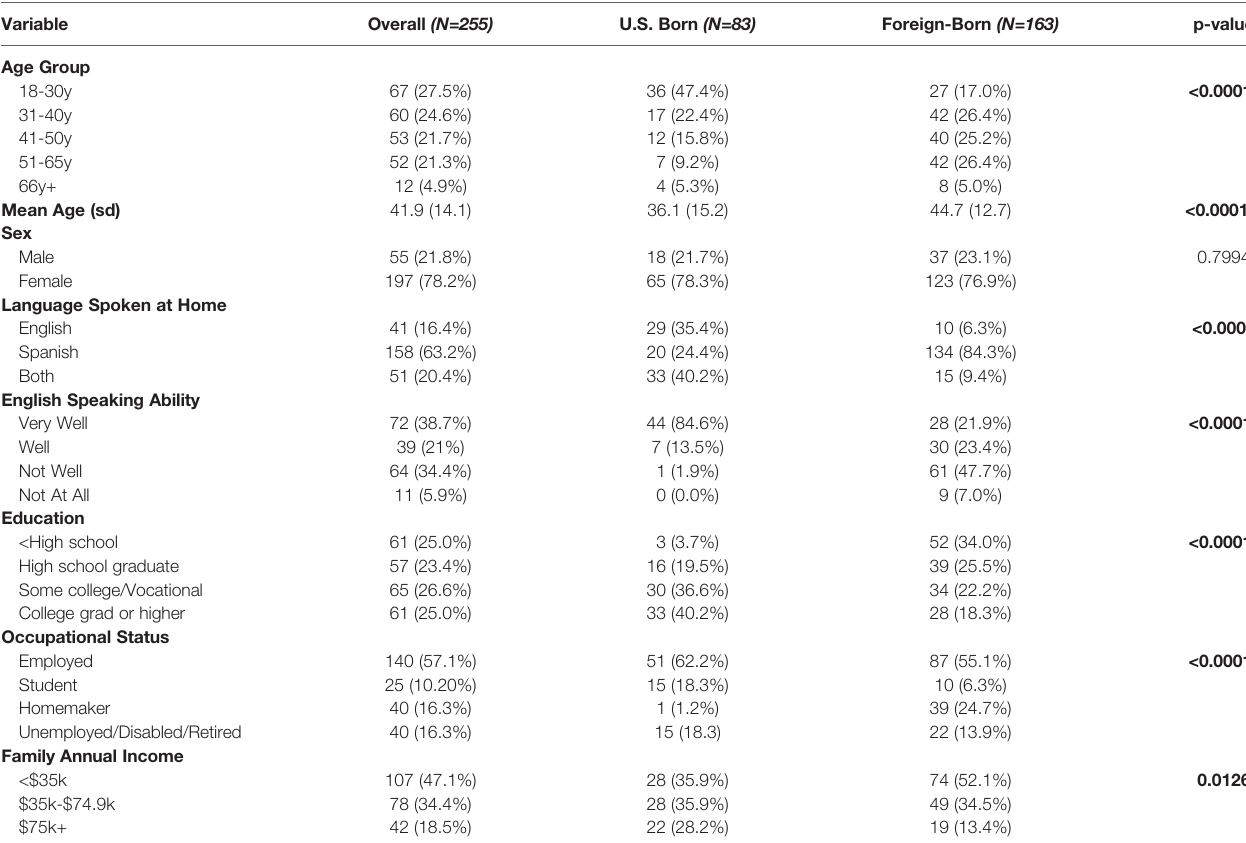
TABLE 1 | Demographics of participants strati fi ed by nativity. (N=246)